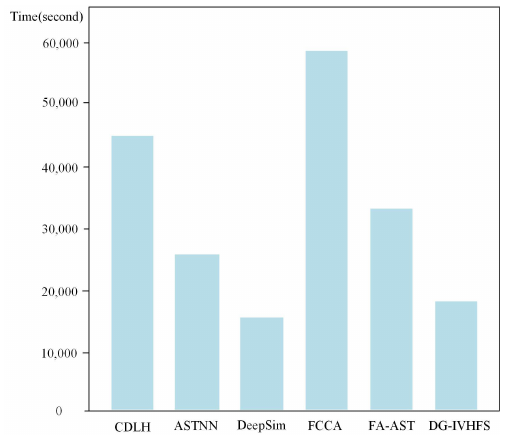
Figure 8. Time consumption of our model based on dual graph convolutional networks and interval- valued hesitant fuzzy set, as well as other baseline models in the training phase.